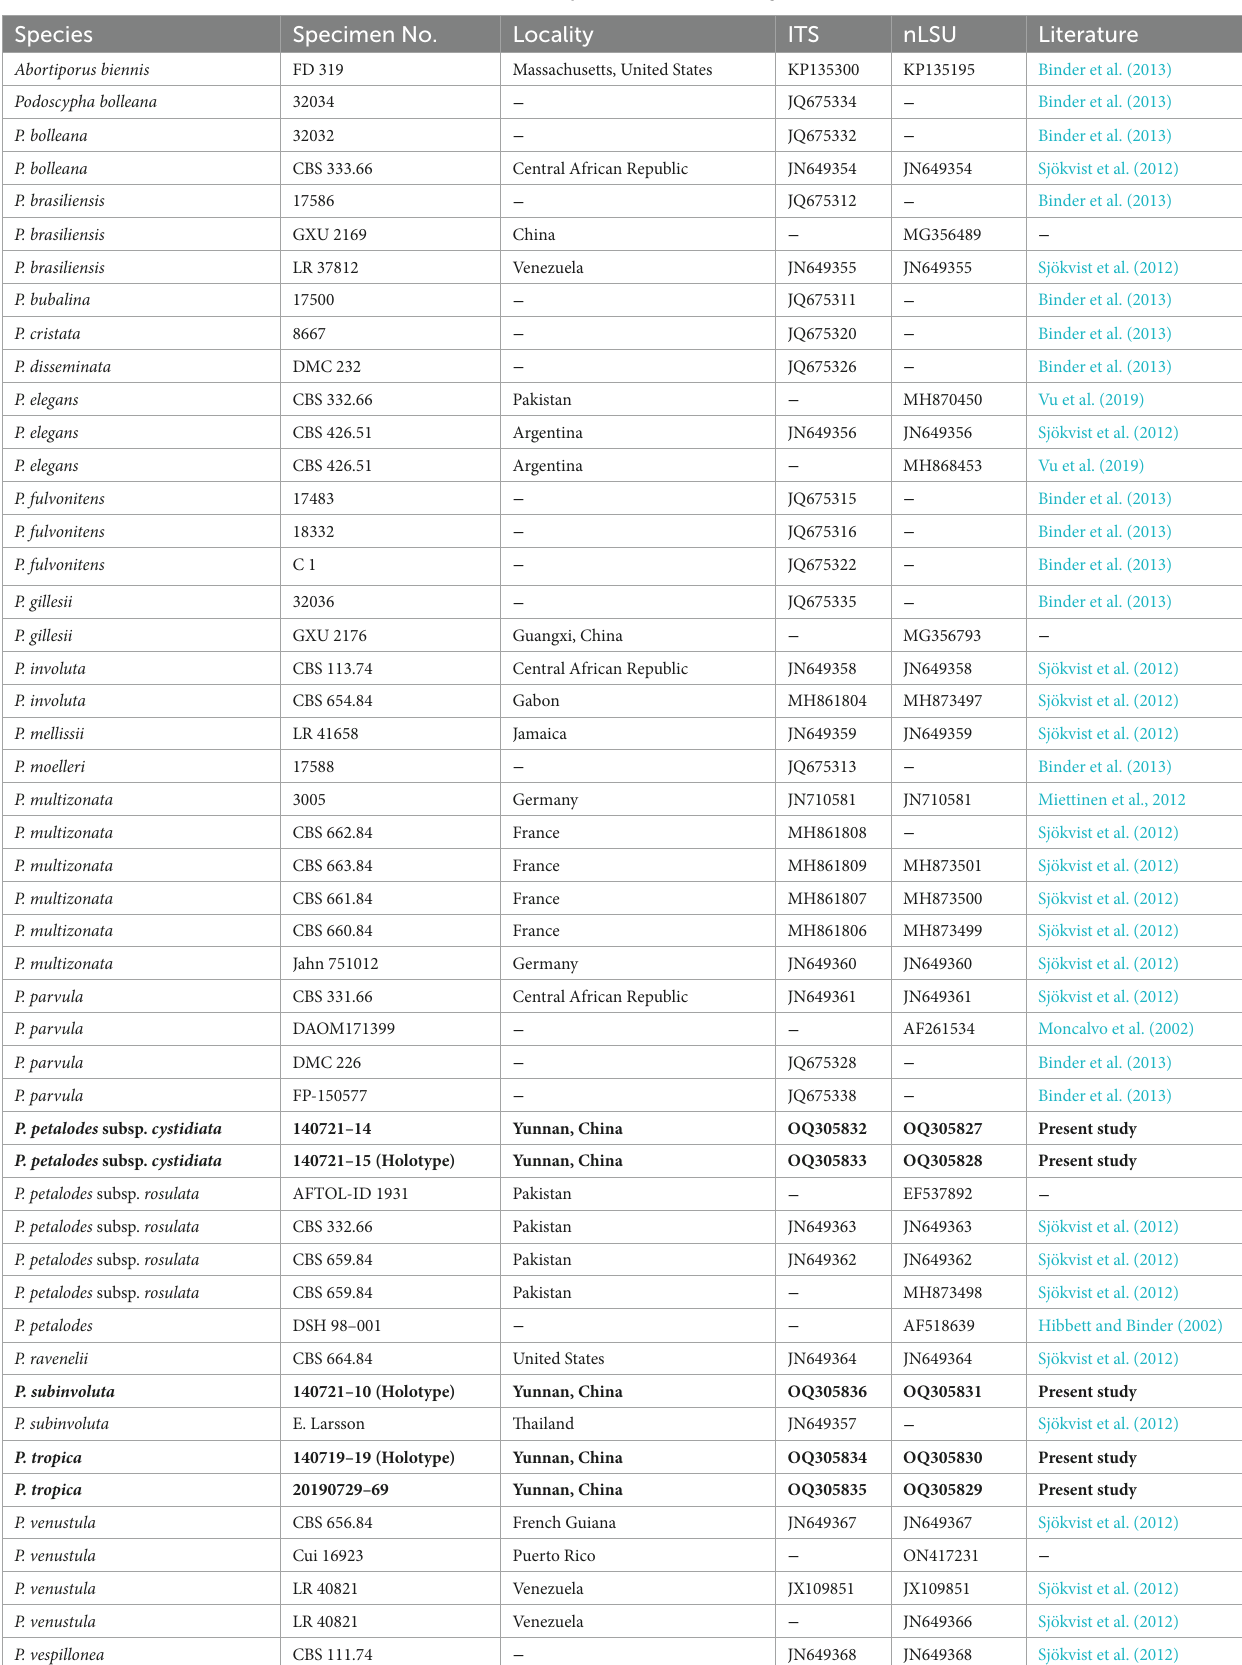
TABLE 1 Taxa information and GenBank accession numbers of the sequences used in this